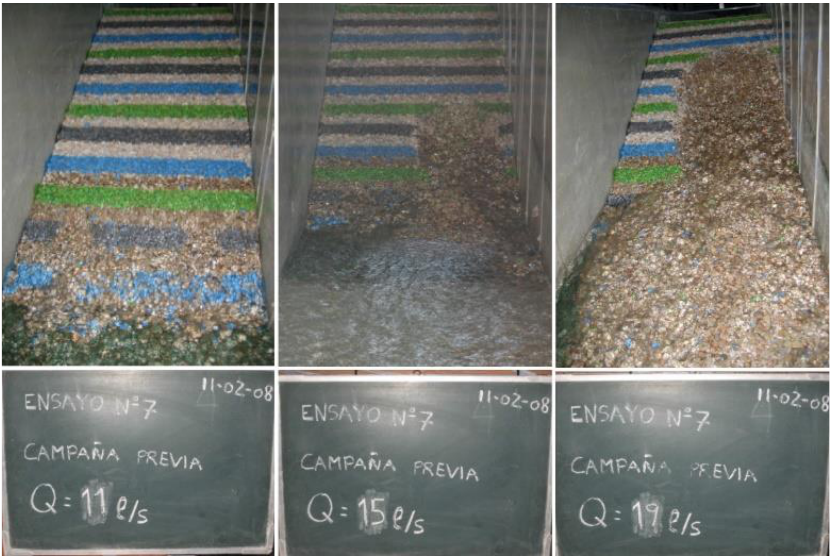
Figure 13. Images of test nº 87 [ 𝑍 dss = 2.2 ].